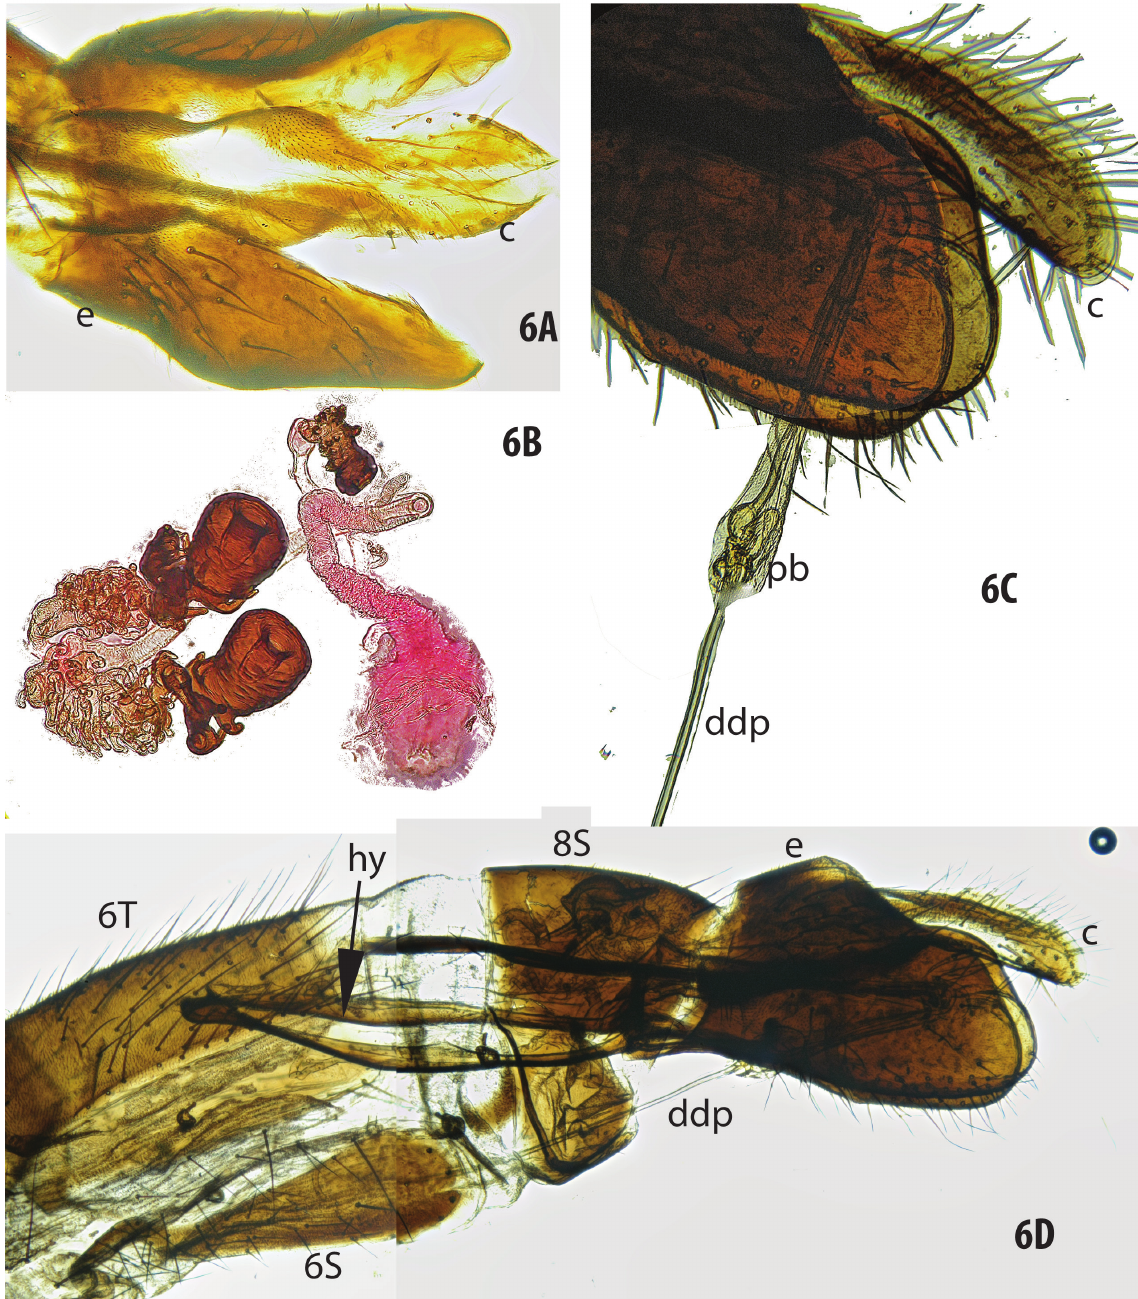
Fig. 6. Mesoconius auristrigatus Enderlein, 1922, internal characters. A . Male epandrium and cerci, posterodorsal view. B . Spermathecae and associated structures. C . Male terminalia with phallus teased out, directed ventrally. D . Apex of abdomen, ♂, lateral view. Abbreviations: c = cercus; ddp = distal distiphallus; e = epandrium; hy = hypandrium; pb = phallic